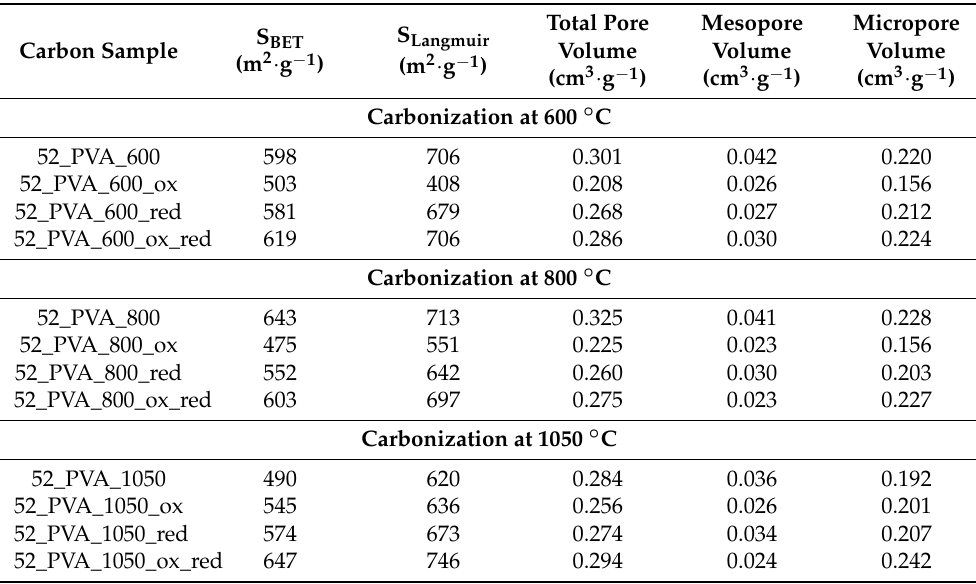
Table 4 summarizes the textural parameters of the studied materials. It can be seen that the activation of the samples carbonized at 600 and 800 ◦ C resulted in a reduction of their porosity and, consequently, their specific surface area. This effect was particularly noticeable after contact with the HNO 3 solution, as a result of which a large number of oxygen-containing surface groups were formed. Their presence most likely blocked relatively narrow micropores. After removing the oxygen functionalities by the reducing agent, the pore system was re-opened and the original textural parameters are restored. In this context, the sample carbonized at 1050 ◦ C with a high degree of graphitization behaved differently. The alignment towards the graphite domains led to the accumulation of amorphous carbon material in the pores after carbonization, which was effectively removed by contact with the HNO 3 solution and gaseous ammonia. Hence, the activation of 52_PVA_1050 had very positive effects by increasing the volume of micropores and the specific surface area. Table 4. Textural parameters of the resol resin-derived carbon materials carbonized at different temperatures and subsequently modified in an oxidizing/reducing atmosphere.